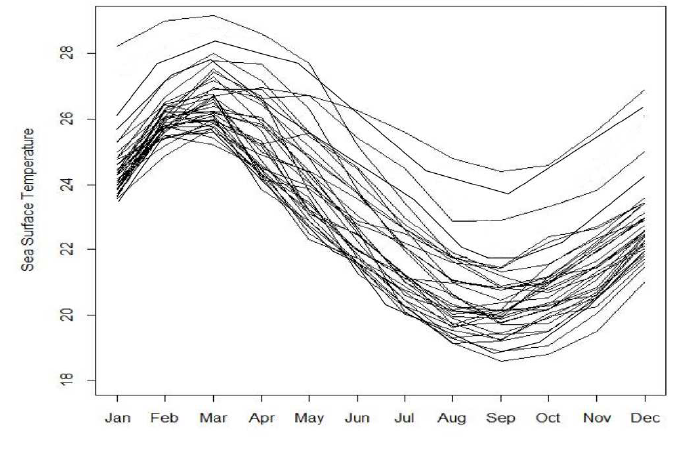
Figure 4. Time series curve of SST in El Ni˜ n o during 31 years.